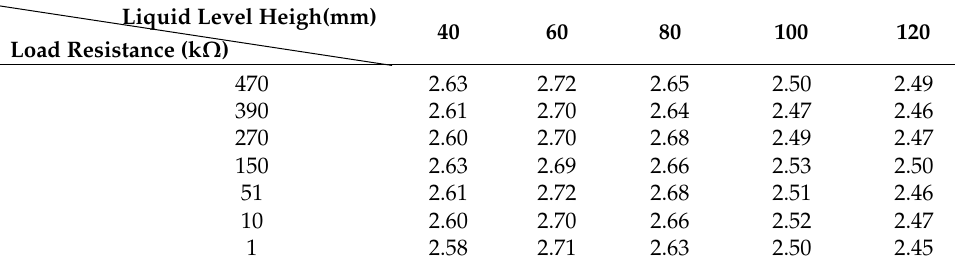
Table 3. Power of the electromagnetic generator under different